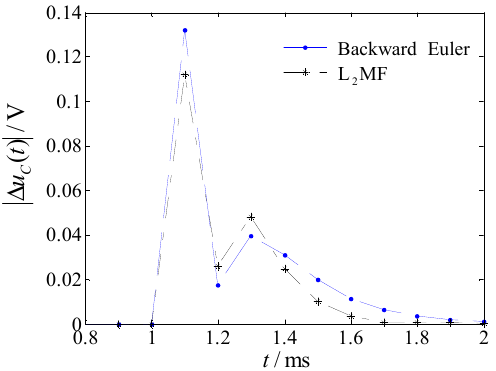
Figure 13. Computation errors of the L 2 MF and backward Euler algorithms as a function of time.